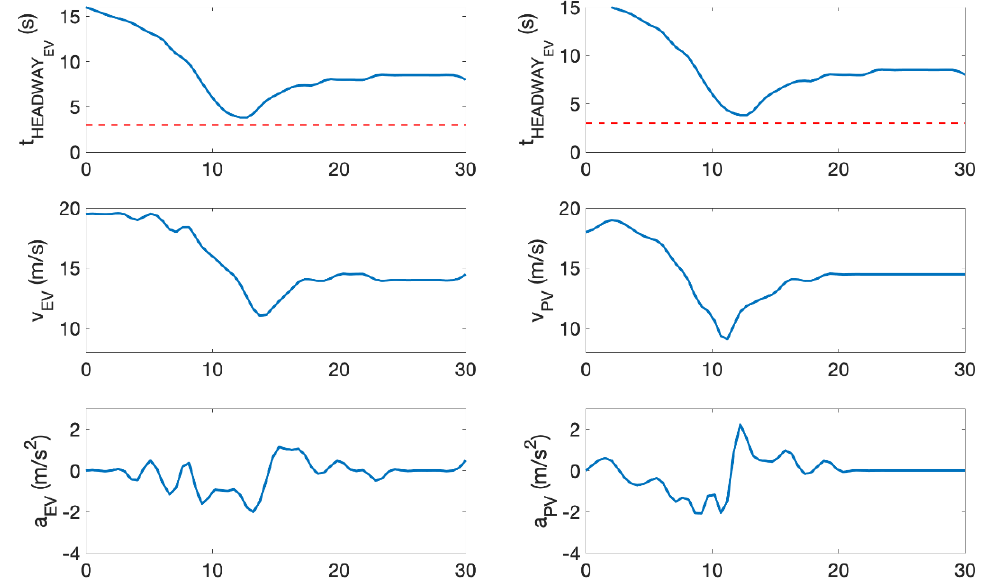
Figure 18. Time headway of ego-vehicle, velocity, and acceleration of ego-vehicle and opponent vehicle.